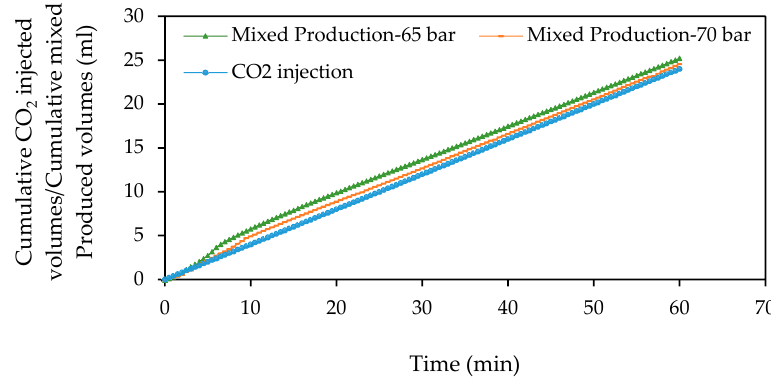
Figure 18. Effect of fluid pressure on the cumulative produced volumes of oil and CO 2 for high-fluid-pressure GCO 2 –oil displacements conducted at 33 °C and 0.4 mL/min.